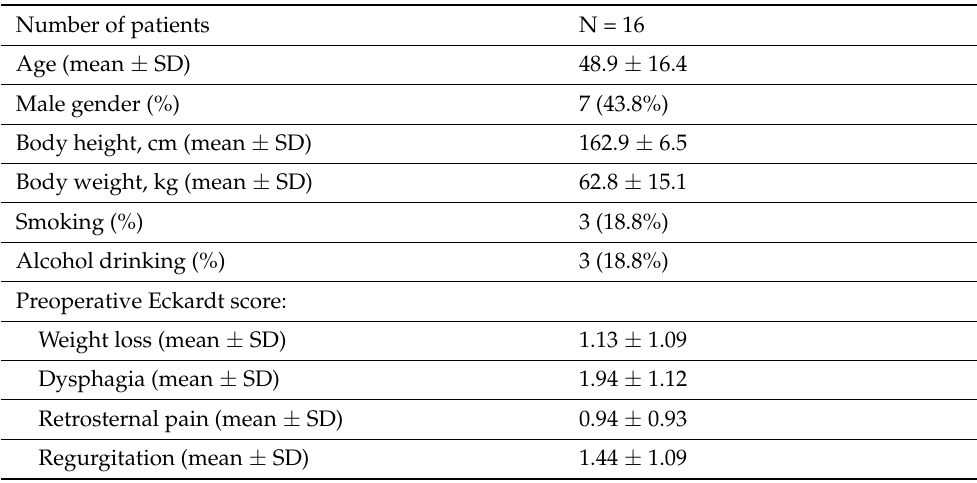
Table 2. Demographics and clinical characteristics of patients with non-spastic motility disorders who received surgical